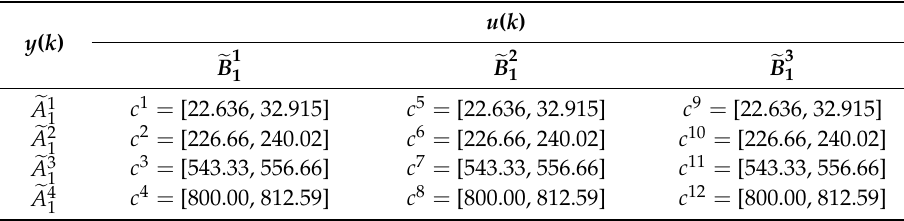
Figure 10. Antecedent membership functions of the IT2-FM. Table 2. The rule base and consequents of the IT2-FM.